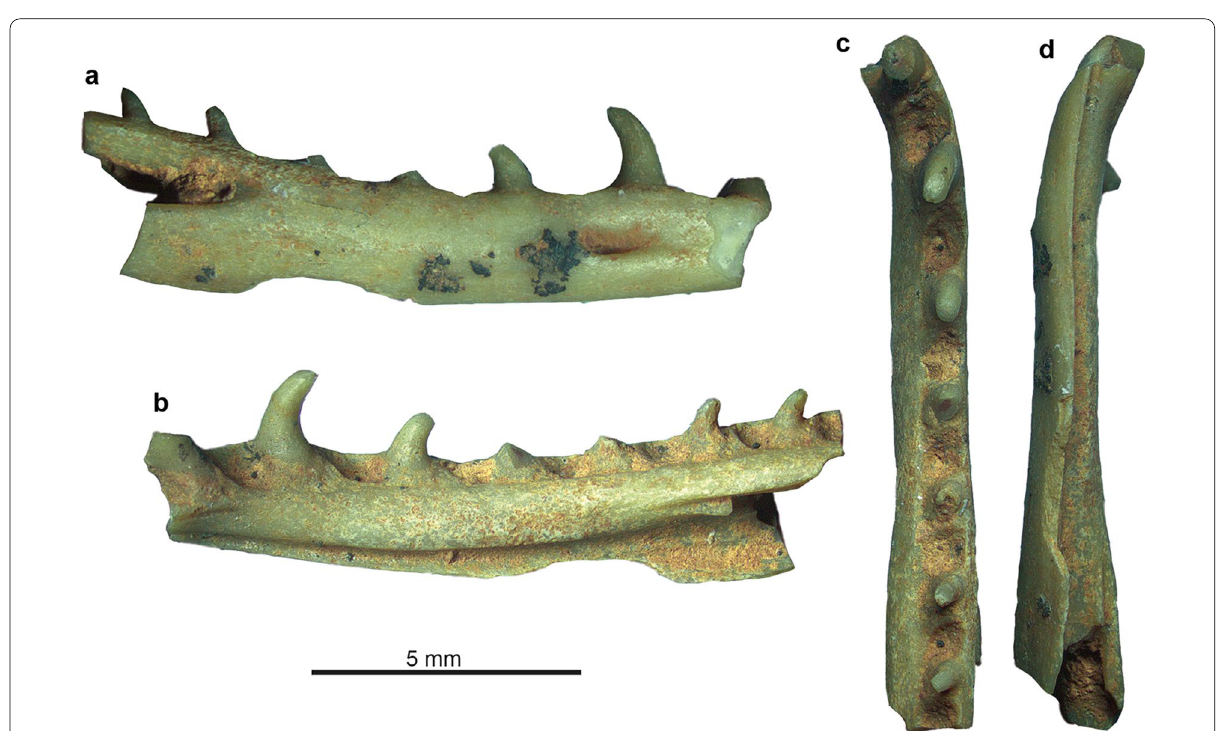
Fig. 104 Constrictores indet. from an imprecisely known locality in the Phosphorites du Quercy: right dentary (NHMW 2019/0020/0003) in labial